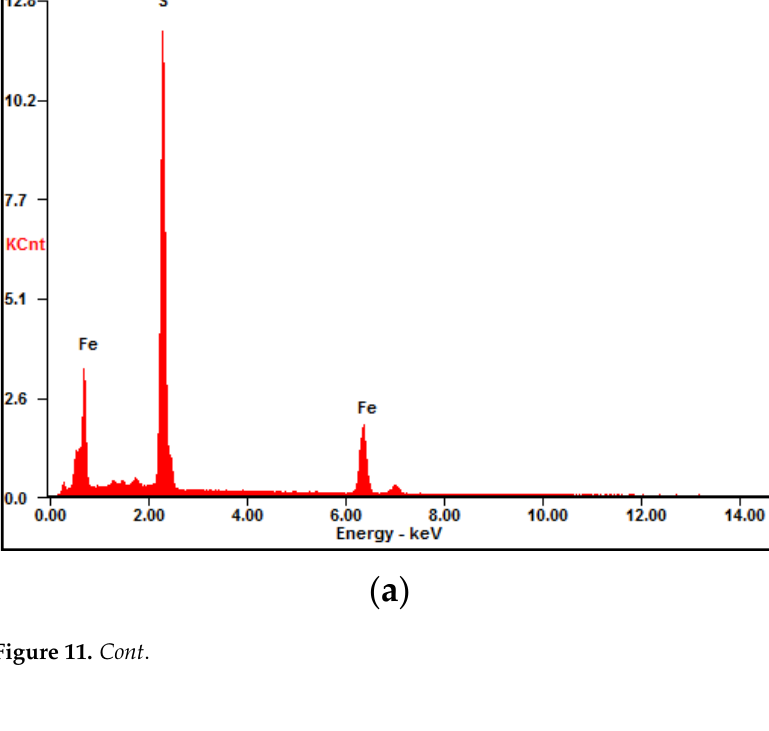
( b ) Figure 11. EDS spectrum: ( a ) untreated ore; ( b ) ultrasonically treated ore. 4. Conclusions The aim of this study was to investigate the use of ultrasonic treatment to treat sulfide ores, so as to enhance microbial desulfurization. On the basis of the results obtained, the conclusions can be made as follows: (1)